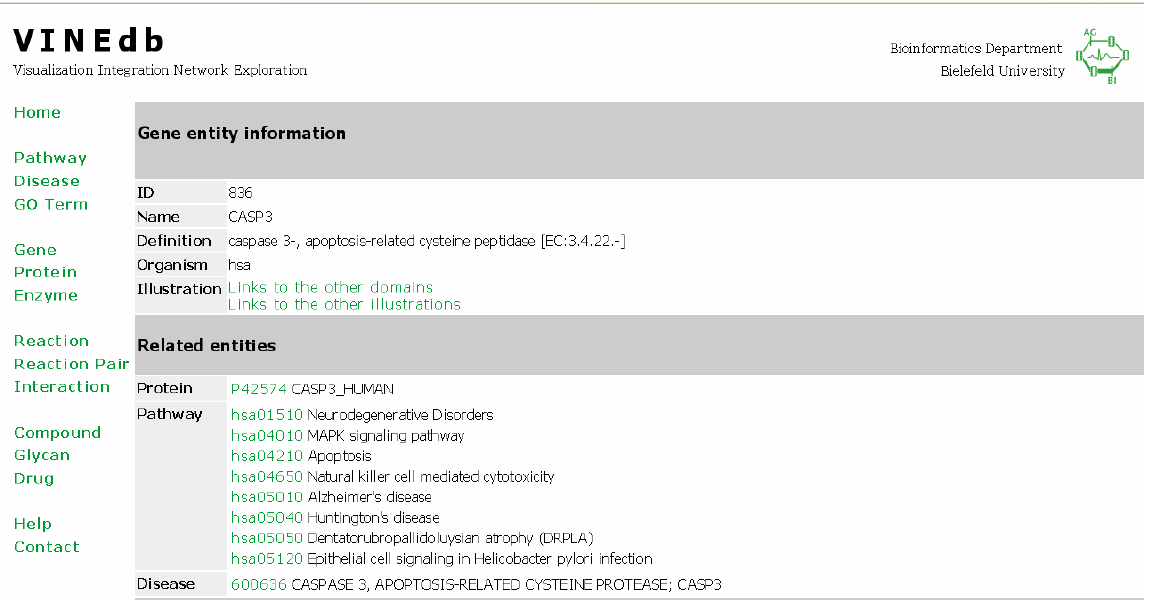
Figure 3: Role of CASP3 in several neurodegenerative diseases as adapted from KEGG